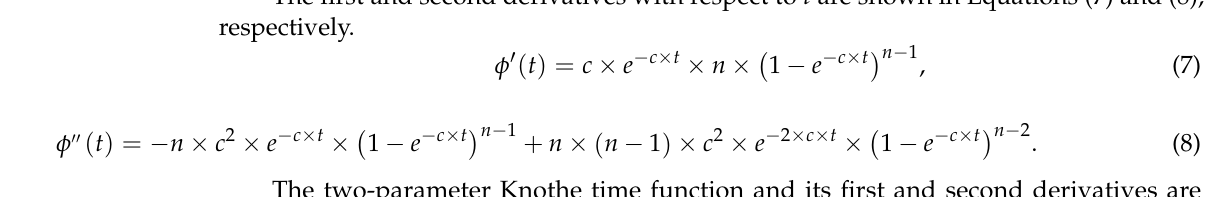
The two-parameter Knothe time function and its first and second derivatives are plotted in Figure 3a,b, respectively.